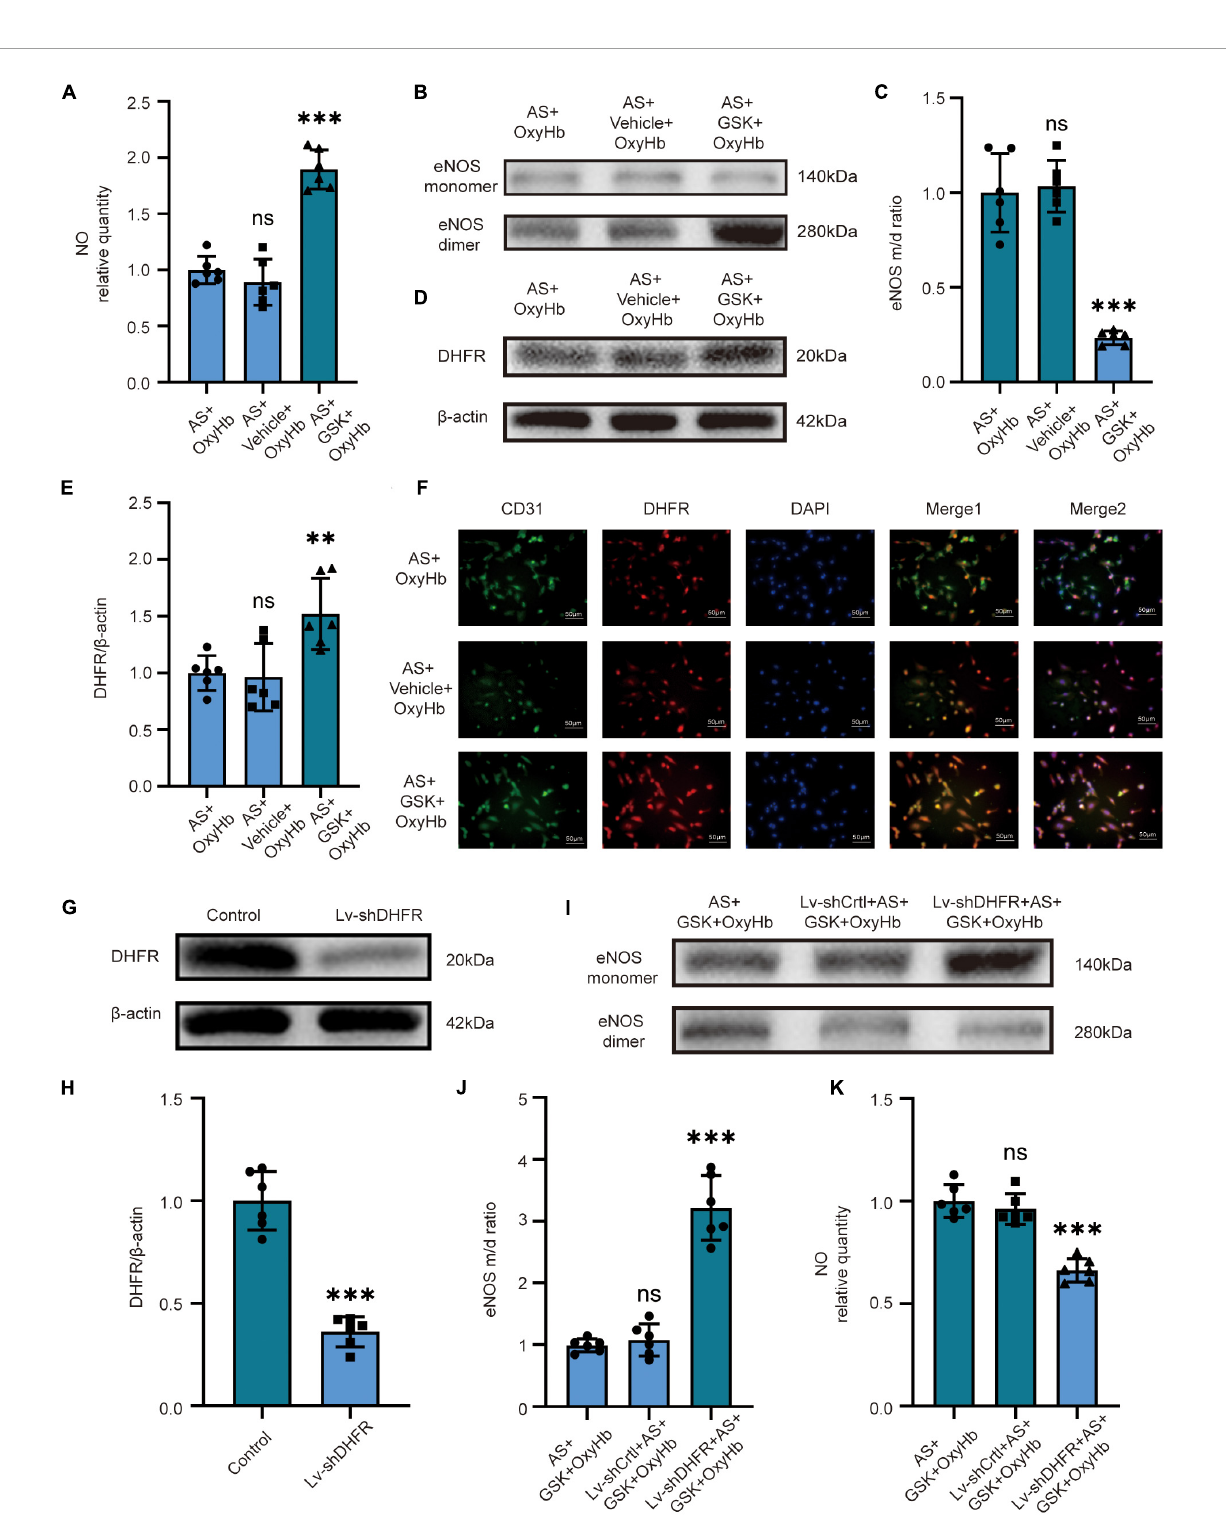
FIGURE3 In vitro , inhibition of NOX2 in astrocytes after SAH recouples eNOS by increasing the expression of DHFR in endothelial cells. In vitro , LV-shDHFR largely attenuated the protective effect of NOX2 inhibitors after SAH. (A) NO released by cells among different experimental groups. Data are shown as mean ± SD ( n = 6 each group, ∗∗∗ p < 0.001, ns: no significant difference). (B,C) Representative Western blot images and quantitative analysis of eNOS monomer and eNOS dimer expression by ImageJ. Data are shown as mean ± SD ( n = 6 each group, ∗∗∗ p < 0.001, ns: no statistically significant difference). (D,E) Representative Western blot images and quantitative analysis of endothelial DHFR expression by ImageJ. Data are shown as mean ± SD ( n = 6 each group, ∗∗ p < 0.01, ns: no statistically significant difference). (F) Immunofluorescence images showed CD31 and DHFR colocalization. All scale bars, 50 µ m. (G,H) Representative Western blot images and quantitative analysis of endothelial DHFR expression by ImageJ. Data are shown as mean ± SD ( n = 6 each group, ∗∗∗ p < 0.001). (I,J) Representative Western blot images and quantitative analysis of eNOS monomer and eNOS dimer expression by ImageJ. Data are shown as mean ± SD ( n = 6 each group, ∗∗∗ p < 0.001). (K) NO released by cells among different experimental groups. Data are shown as mean ± SD ( n = 6 each group, ∗∗∗ p < 0.001, ns: no statistically significant